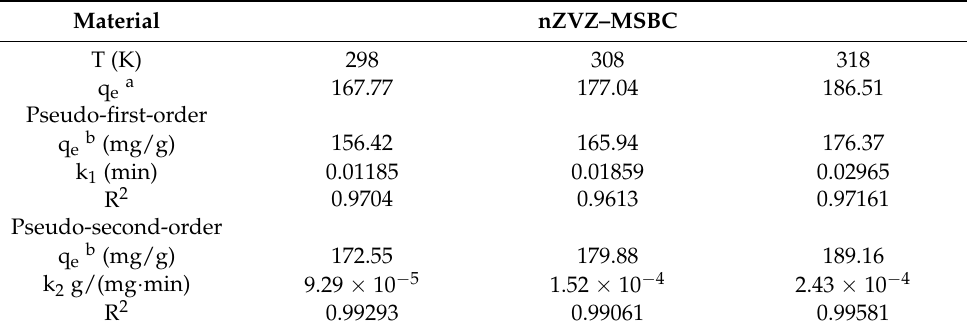
Table 2. Adsorption kinetic parameters of the